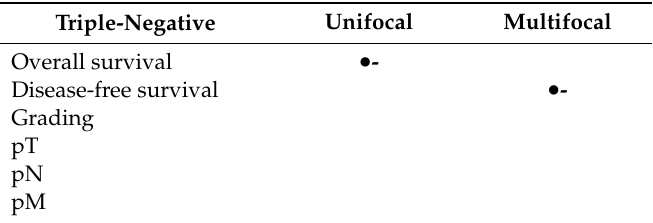
Table 5. Significant results for the triple-negative patients.